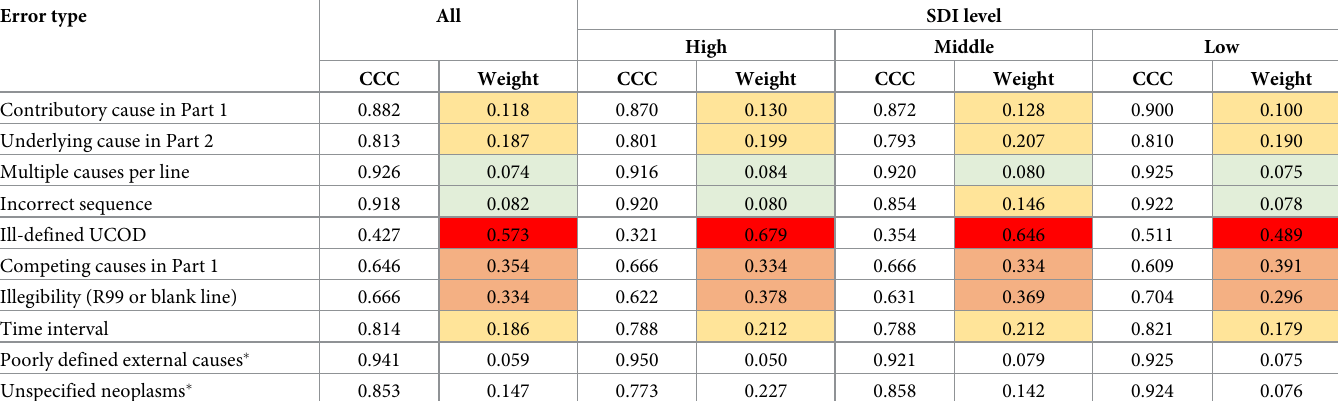
Table 1 presents the CCC and weights for each error-type and SDI level. For all causes in our sample (high, medium and low SDI populations), the only very high impact error type was ill- defined underlying cause of death , where over half of all MCCODs had their UCOD changed due to this error (weight 0.573). High impact errors across all MCCODs were reporting Table 1. Chance-corrected concordance (CCC) and weights by error type and SDI